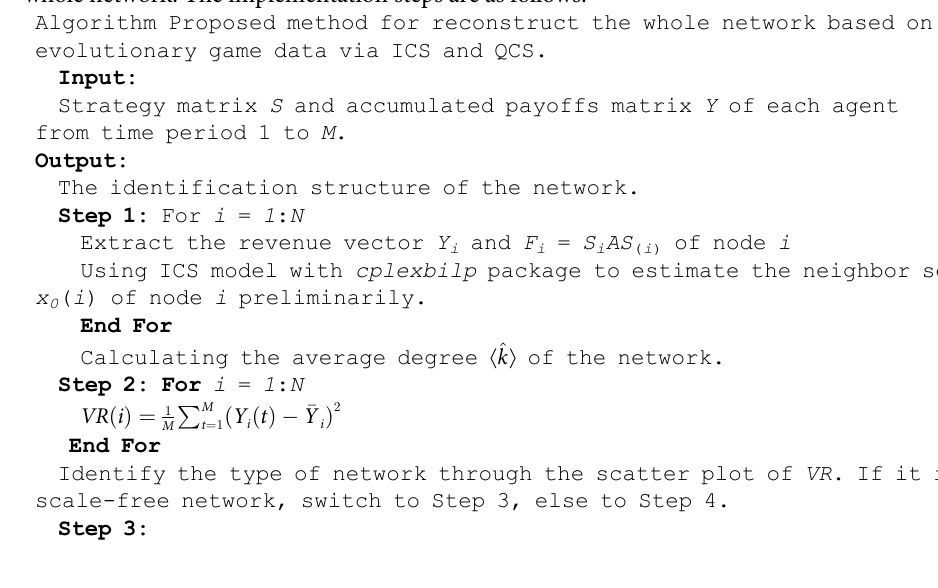
Algorithm Proposed method for reconstruct the whole network based on evolutionary game data via ICS and